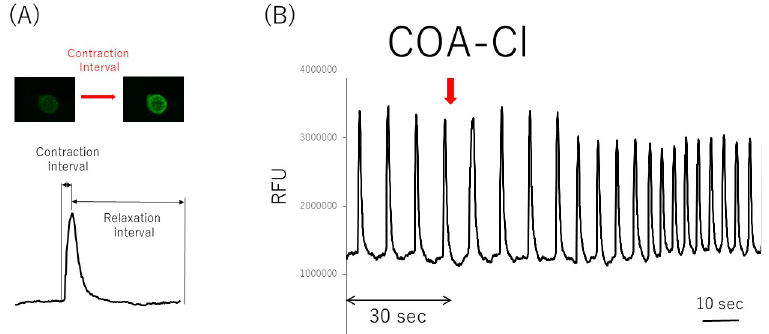
Fig 5. The contraction of pure hiPSC-CM spheroids was visualized using Fluo-4 (a calcium indicator). Pure hiPSC-CM spheroids were then loaded with Fluo-4, which fluoresces upon calcium binding. Representative still images of resting and contracting pure hiPSC-CM spheroids, taken from a time-lapse video capturing the calcium influx during contraction. Rate-interval graph demonstrating spheroid contraction as measured by recording the changes in the Fluo-4 fluorescence intensity. The contraction interval was determined as the time between low Fluo-4 fluorescence (relaxed cells) and high Fluo-4 fluorescence intensity (contracted spheroids) (A). COA-Cl increased the beating rate of pure hiPSC-CM spheroids in the early phase. The medium was loading buffer. Pure hiPSC-CM spheroids were assessed to determine their ability to contract using a Fluo-4 calcium binding assay. The rate interval graph shows fluctuations in the Fluo-4 fluorescence intensity, indicative of pure hiPSC-CMs spheroid contraction, under basal conditions for 30 s and after sequential treatment with COA-Cl. COA-Cl affected the rate of contraction at an early stage. The contraction rate of differentiated pure hiPSC-CM spheroids was determined as the number of contractions (contraction interval + relaxation interval) per minute. The data were from nine individual experiments, each of which was performed three times